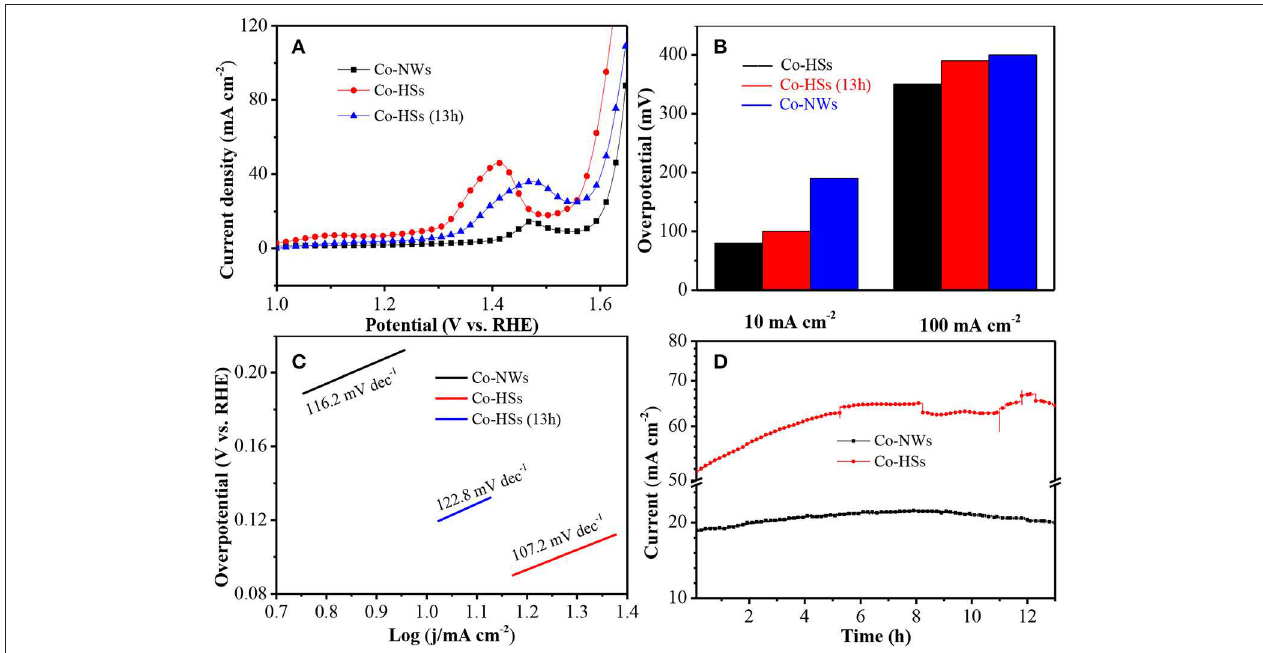
FIGURE 4 | Electrochemical measurements of Co-NWs, Co-HSs, and Co-HSs (after 13h), (A) LSV curves, (B) Comparison of the overpotential at the current densities of 10 and 100mA cm − 2 , (C) Tafel plot, and (D) long cycle stability.